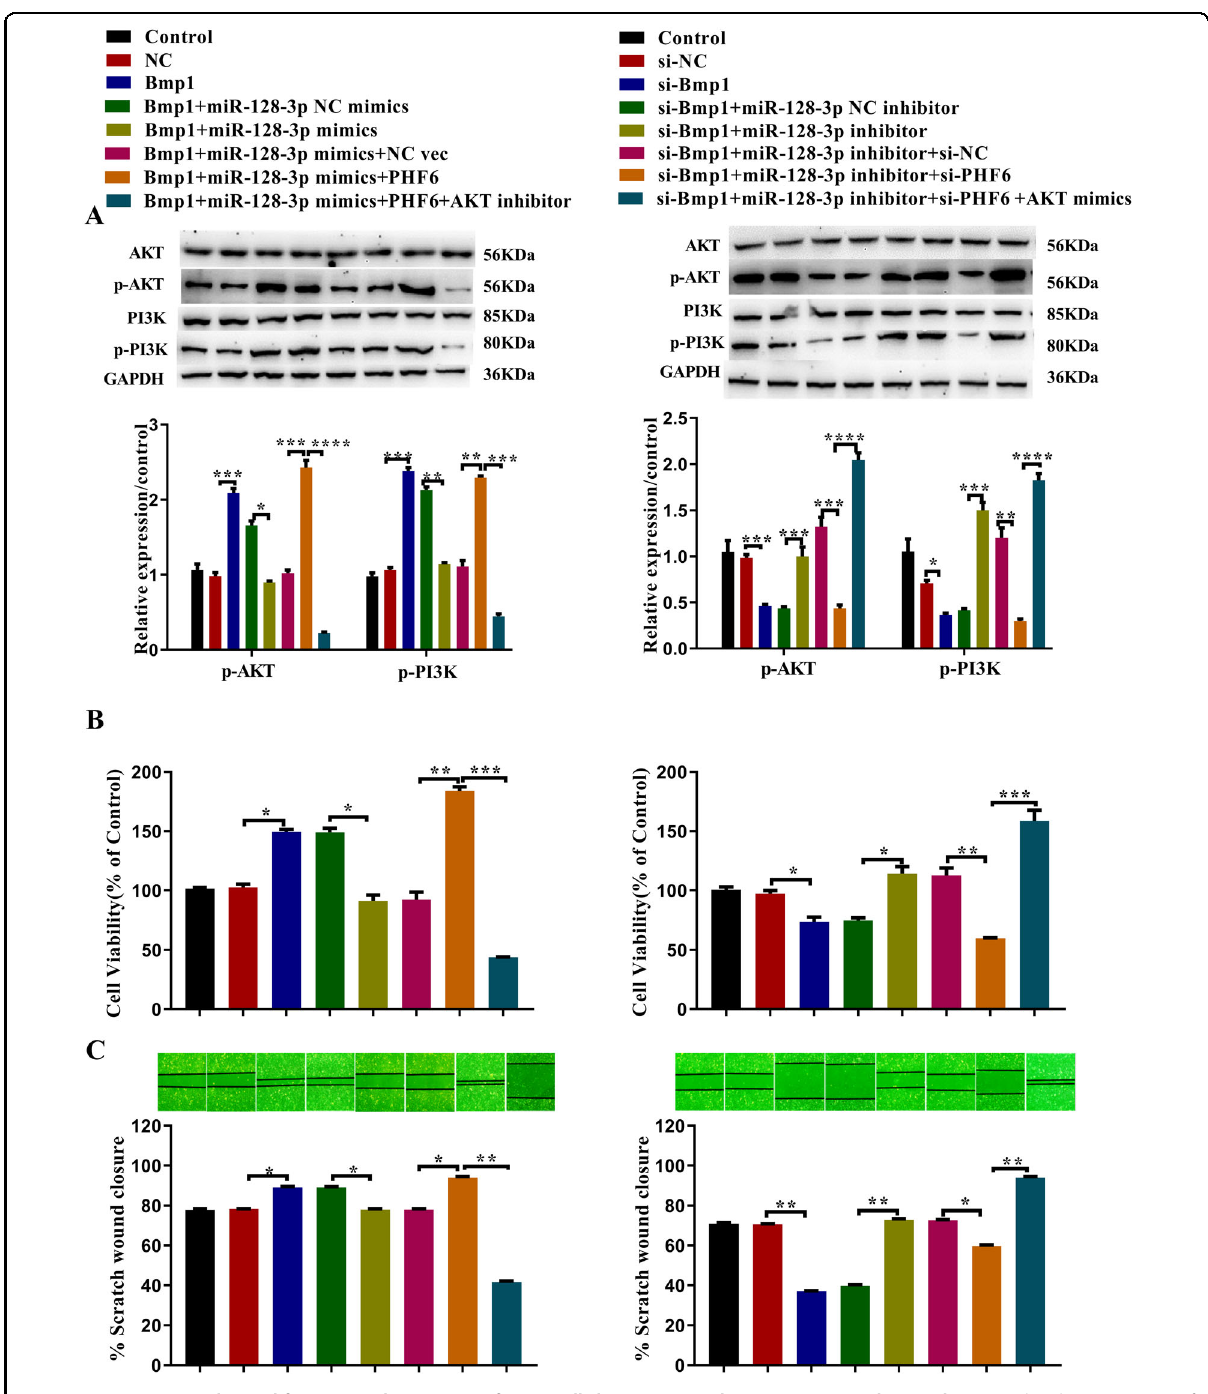
Fig. 8 PHF6 promotes the proliferation and migration of IEC-6 cells by activating the PI3K/AKT signaling pathway. A The alter expression of PI3K, p-PI3K,AKT, p-AKT in treated IEC-6 cells ( n = 3), B cell viability ( n = 3), C cell migration ability were analyzed using western blot, cell counting kit- 8 assay, and wound healing assay, respectively ( n = 3). All data were demonstrated as mean ± SD from three independent experiments performed in duplicate. * p < 0.05, ** p < 0.01, *** p < 0.001 and **** p < 0.0001 were all signi fi cant